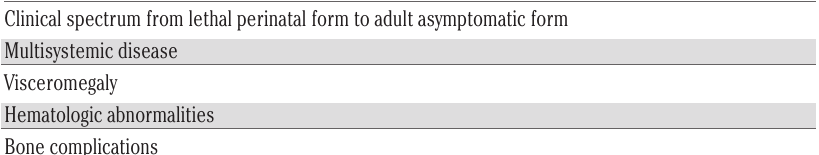
Table 1. Non-cardiac red